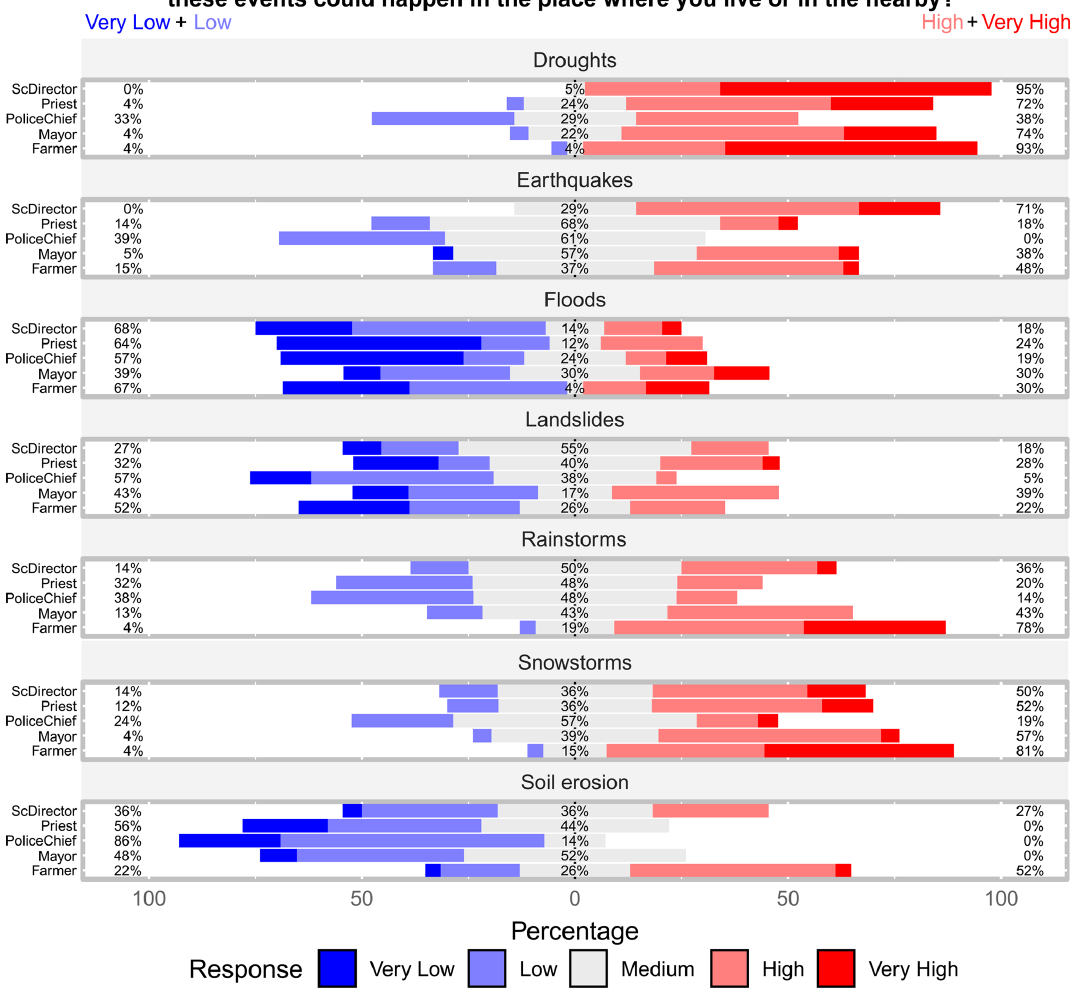
Figure 7. The Likert plot of the stakeholders’ responses regarding the perceived likelihood of different natural